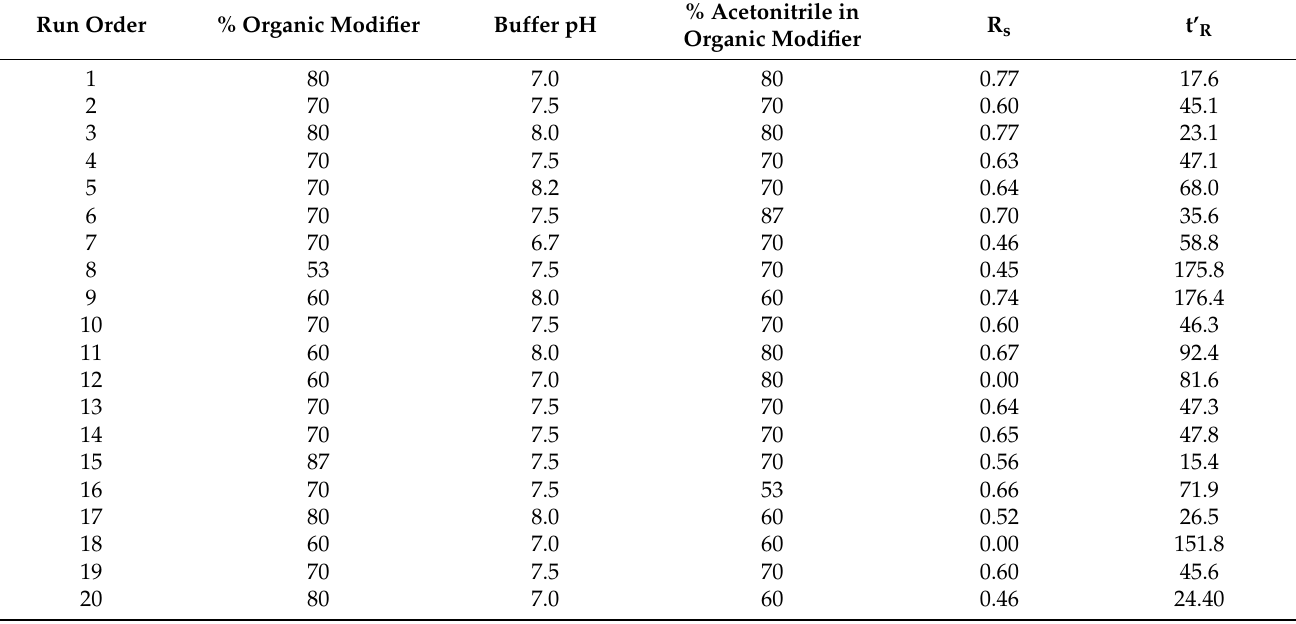
Table 1. Run conditions (20) for the central composite optimization design and the resolution (R s ) and retention time of the late eluting peak (t’ R ) as